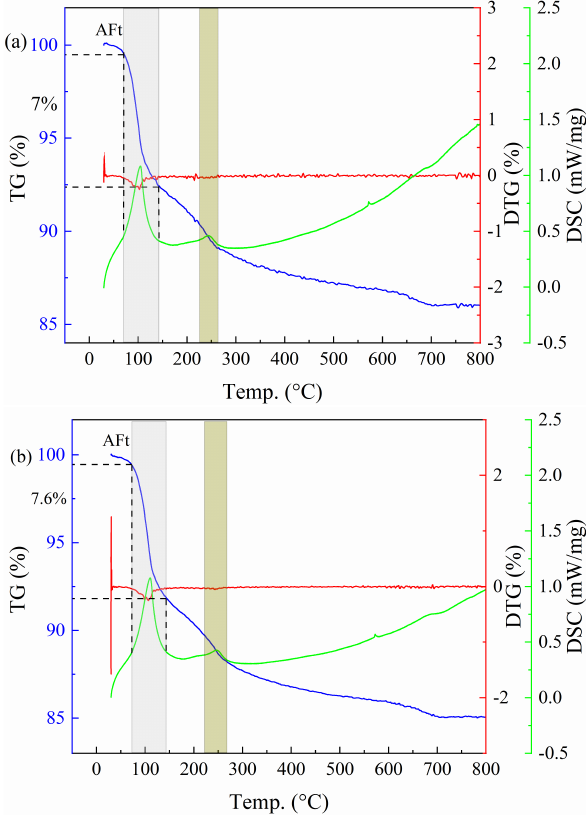
Figure 5: DSC, TG and DTG patterns of samples at the age of 6h. (a) DSC, TG and DTG patterns of SAC; (b) DSC, TG and DTG patterns of GO-SAC